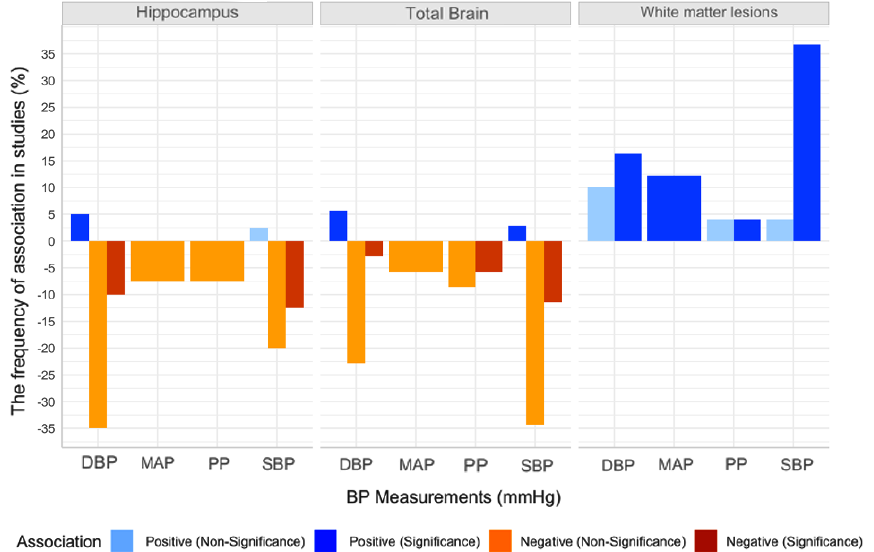
Figure 3. Proportion of the studies included in the systematic review ( n = 52; sample size, n = 343,794), that reported an association between blood pressure (BP) and volumes of different brain regions. Notes. Where studies reported on different types of BP measurements, different measures were included in separate analyses. Systolic BP (SBP), diastolic BP (DBP), pulse pressure (PP), and mean arterial pressure (MAP).